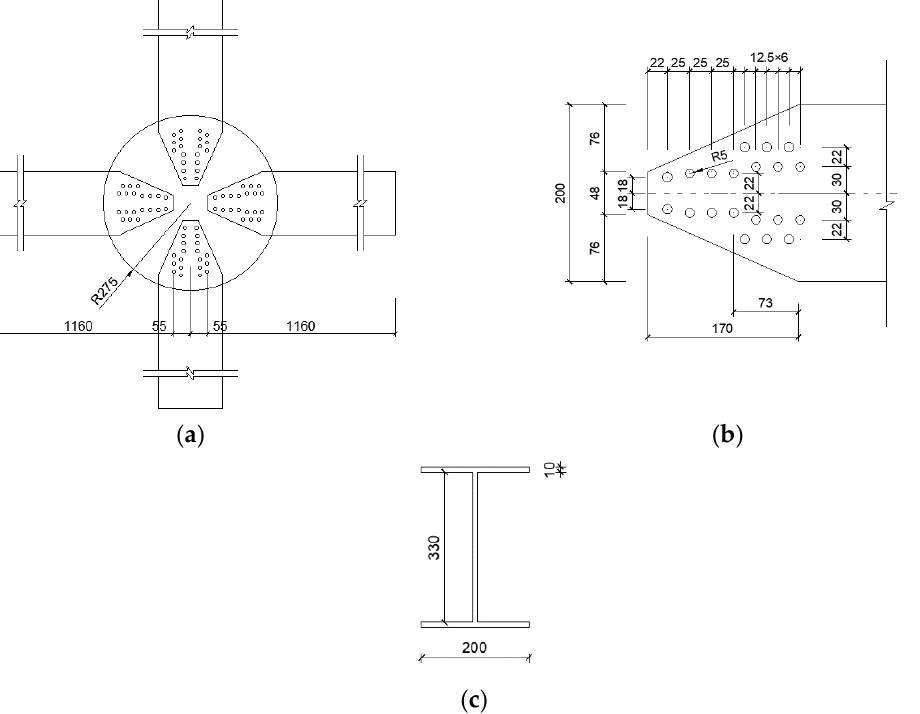
Figure 6. Geometric dimensions of the AAG joint. ( a ) Diagram of plane view of the AAG joint; ( b ) diagram of details of member in joint domain; ( c ) diagram of member section.